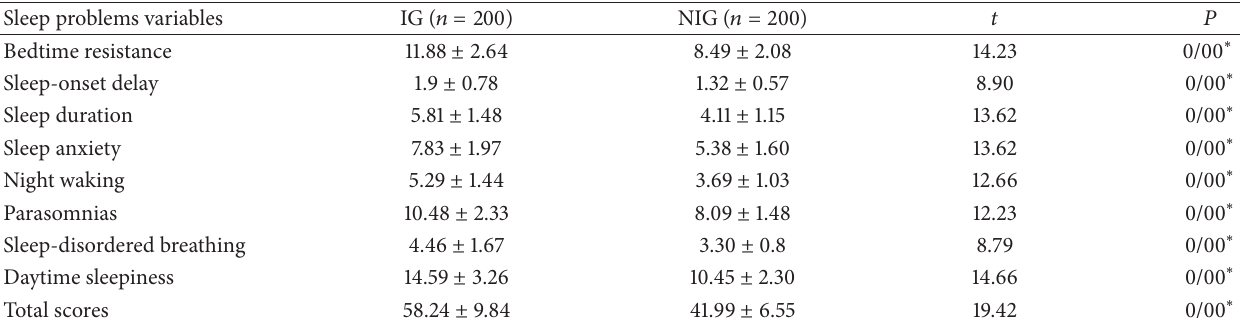
Table 1: Comparison of CSHQ scale scores between the IG and NIG means ± SD.